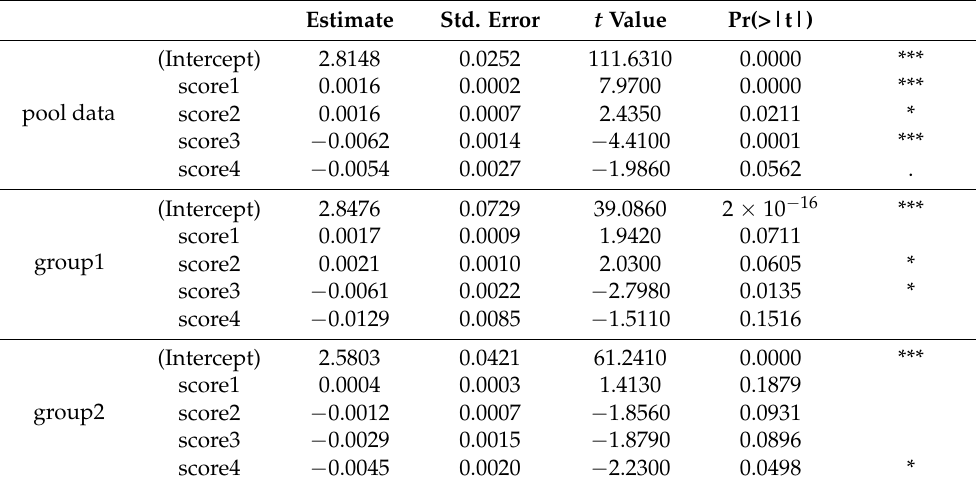
The regression results for both the pooled data and the clustered data given by the FCR-HL model. Estimate Std.